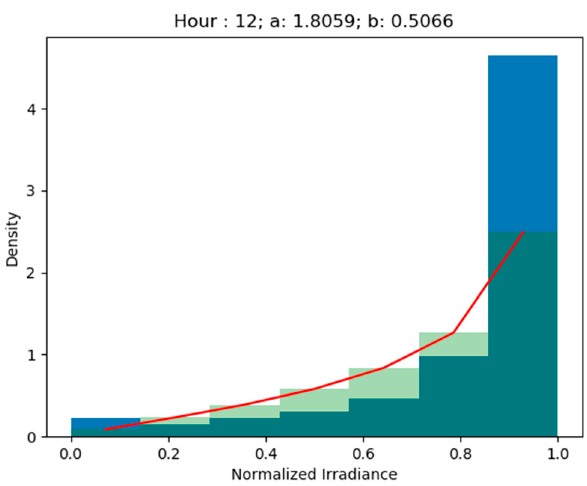
Figure 4. Data fitting using beta distribution with 7 regions: (blue bars) histograms of the empirical distribution; (green bars overlaid with transparency) histograms of the fitted beta distribution; (red line) the line connecting the central points of all regions.